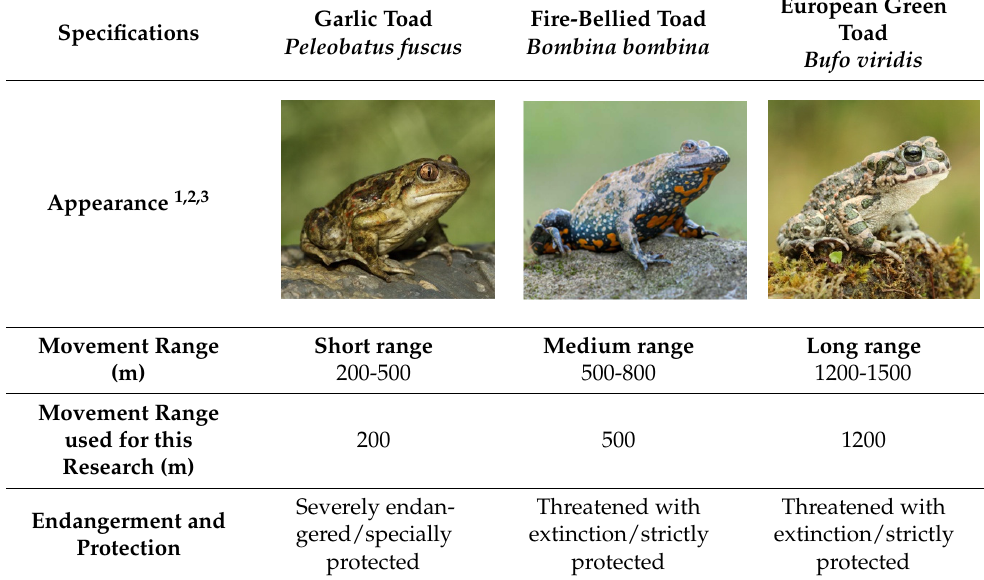
Table 1. The characteristics of the three studied indicator species: appearance, movement ranges where genetic exchange considered “good to medium” according to Berger et al. [14], as well as endangerment and protection status according to the German Nature Conservation Act (BNatSchG).